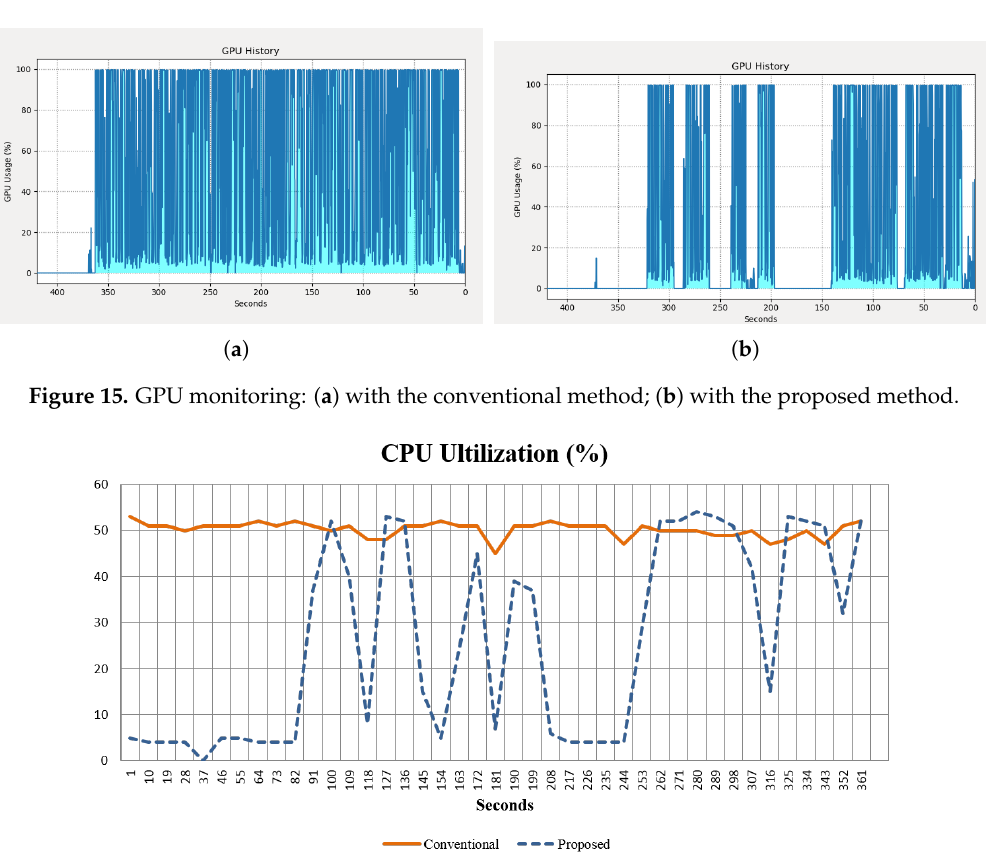
Figure 16. CPU monitoring with both the conventional method and the proposed